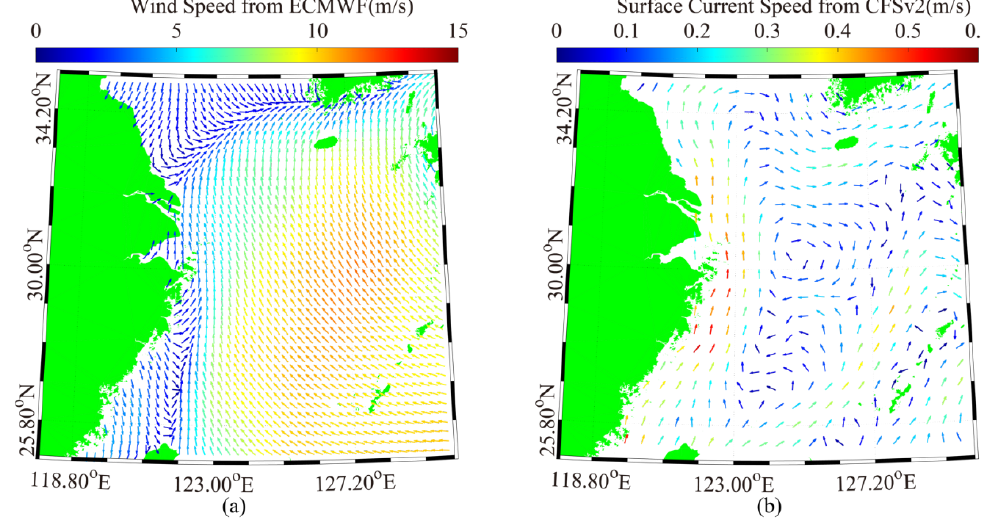
Figure 3. ( a ) The sea-surface wind map from European Centre for Medium-Range Weather Forecasts (ECMWF) taken at 00:00 on 16 January 2018; ( b ) The sea-surface current map from Climate Forecast System Version 2 (CFSv2) taken at 22:00 on 15 January 2018.